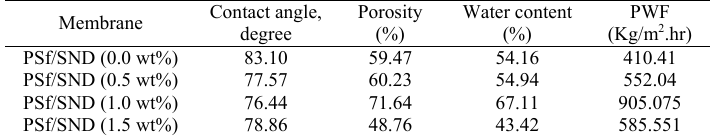
Table 2. Contact angle, porosity, water content and PWF results for neat and nanocomposite PSf membranes. Membrane